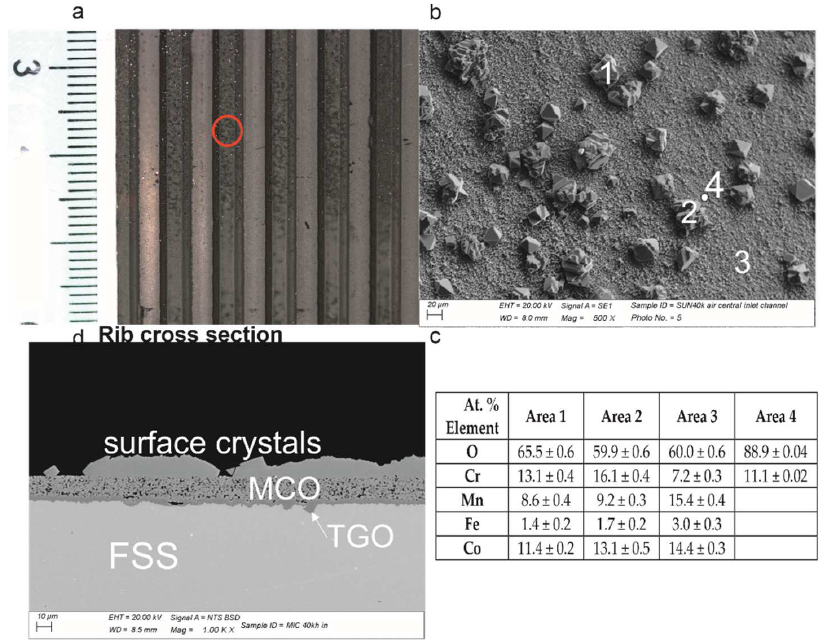
Figure 3. From top-left clockwise: ( a ) the interconnect aspect at the inlet with dark crystals on top of the MCO at the channel; ( b ) SEM-BSE details of the channel with crystals on top; ( c ) EDXS analyses; ( d ) cross-sectional features representative of the three layers (i.e., from top to bottom: surface crystals, MCO and